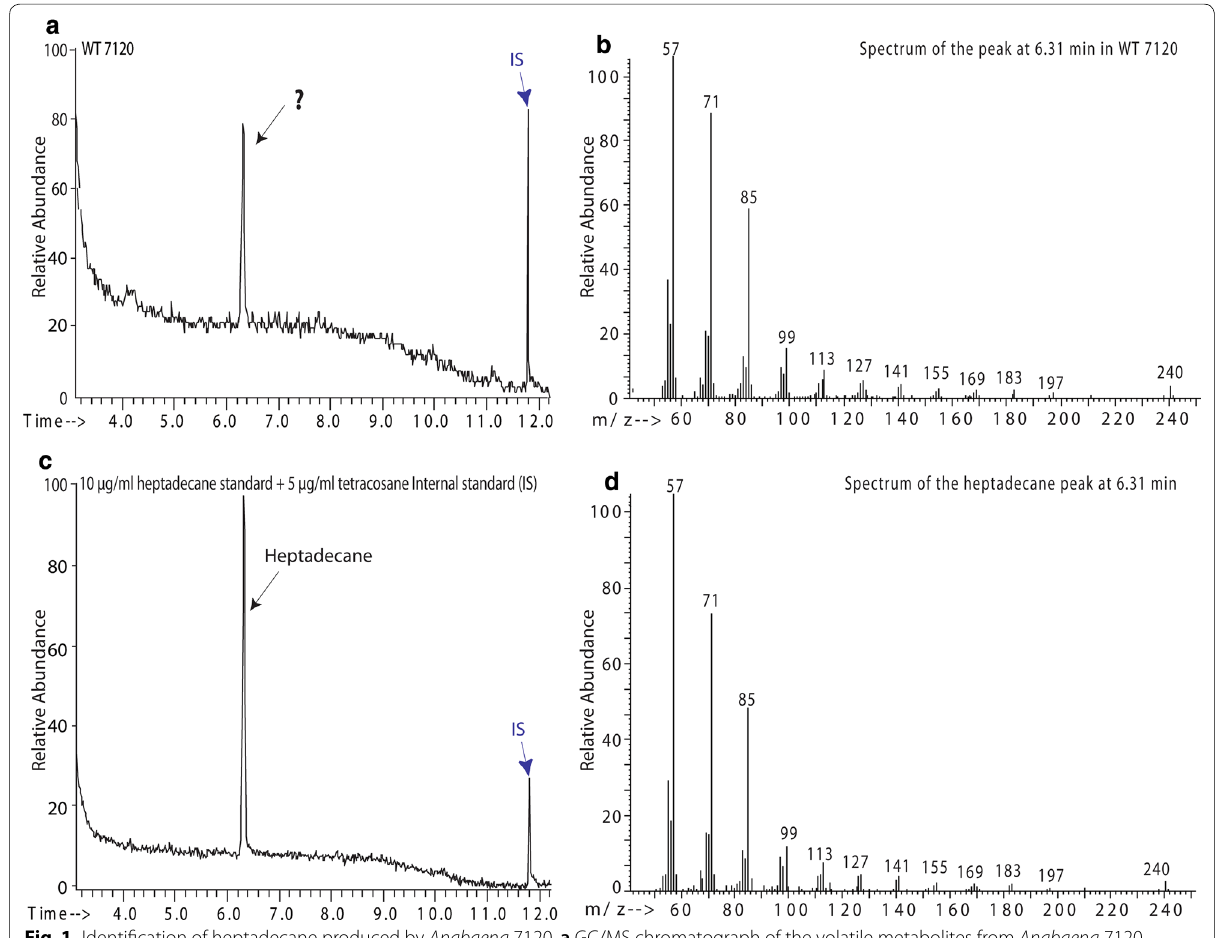
Fig. 1 Identification of heptadecane produced by Anabaena 7120. a GC/MS chromatograph of the volatile metabolites from Anabaena 7120 cultures. A peak at the retention time of 6.31 min (black arrow) found in Anabaena matches the heptadecane standard ( c ). b , d Mass spectra of the 6.31 min peaks display the fragmentation pattern for the compound in Anabaena and the heptadecane standard, respectively. Five μg mL − 1 tetracosane serves as an internal standard (IS, blue